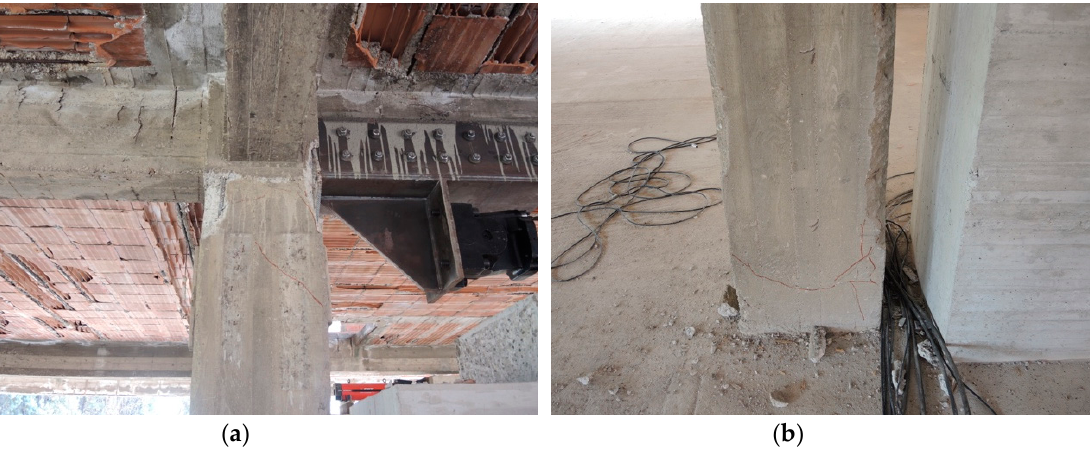
( b ) Figure 19. Run #9, 62.4 mm—1.69%: Flexural cracking pattern and failures at the base of columns c4 ( a ) and c18 ( b ). ( c ) Figure 20. Run #9, 62.4 mm—1.69%: Shear failures, columns c17 ( a ) and c9 ( b ) and ( c ).